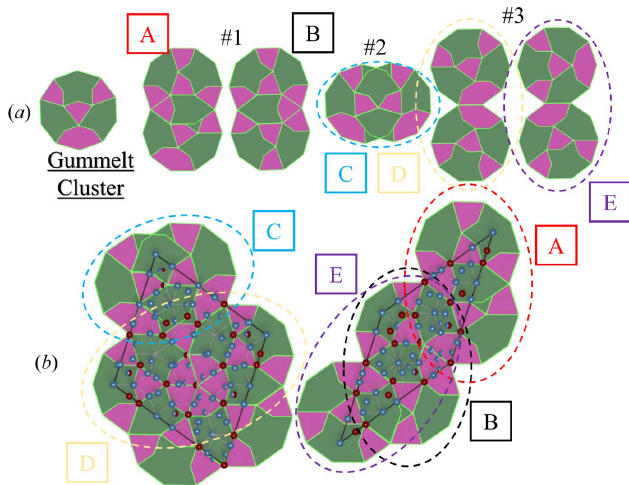
Figure 10 Decoration of the refined units of the RPT with Gummelt clusters. The overlap rules for Gummelt clusters are shown. The m symmetry of the decorated Gummelt clusters by atomic species is broken which means that our model cannot be explicitly explained on the basis of Gummelts cluster.